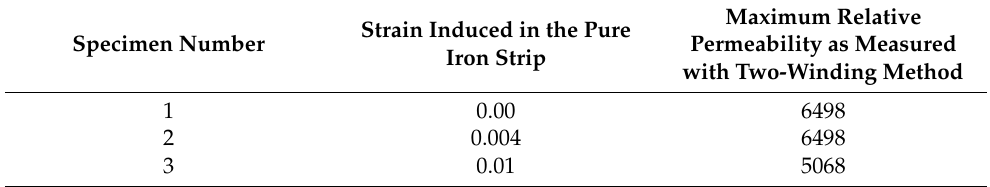
Table 8. Effect of plastic deformation on maximum relative permeability of pure iron.